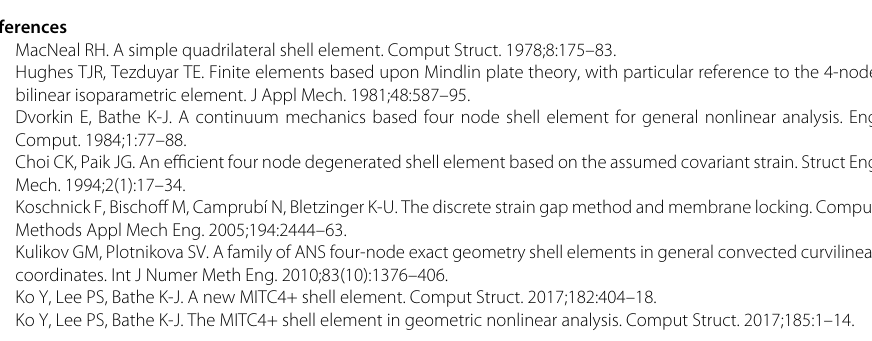
shape factor has to be used with c = 0. A well-known feature of present element formula- tion is the remarkable robustness in nonlinear applications. It allows very large load steps in comparison to element formulations based on the displacement method or enhanced strain